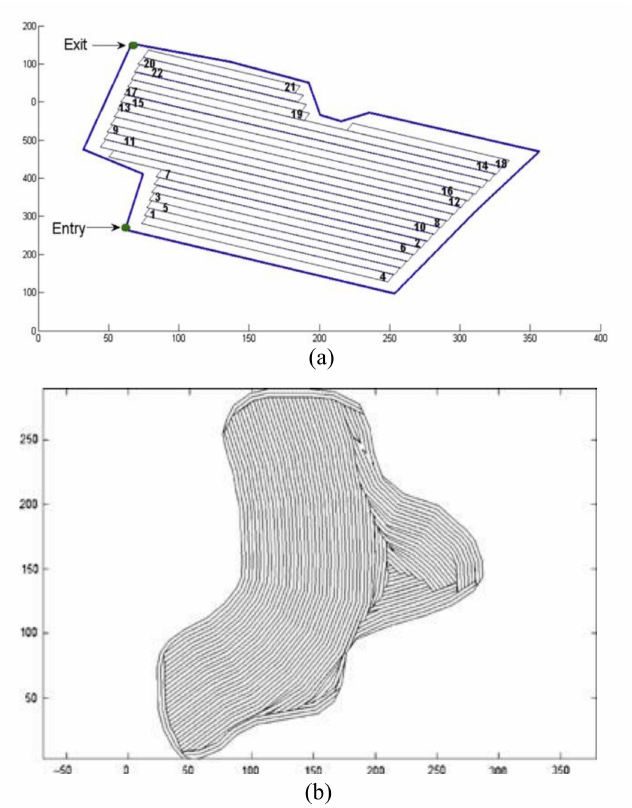
Figure 2. ( a ) Path plan without considering geometry [67]; ( b ) path plan considering geometry